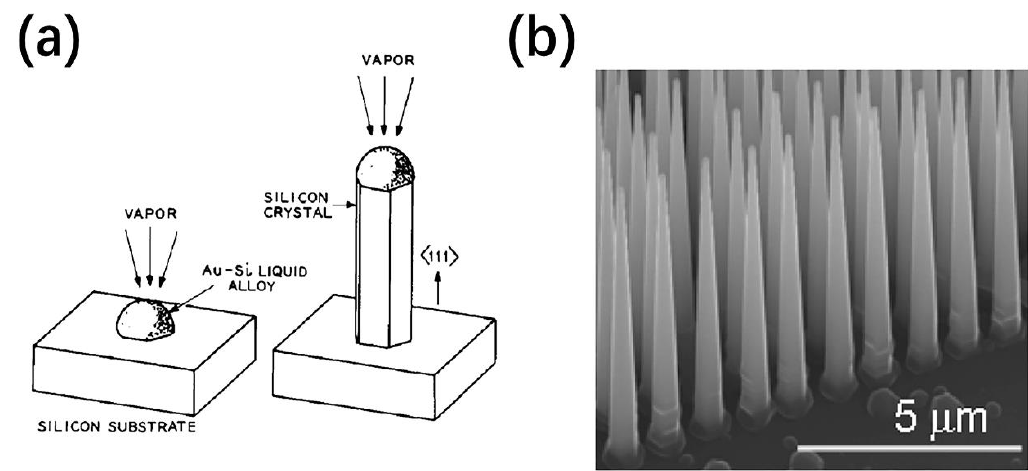
Figure 1. ( a ) Schematic illustration of the vapor-liquid-solid (VLS) growth method. Silicon crystal grows with liquid alloy at the tip [15]; ( b ) scanning electron microscope (SEM) image of SiNWs (nanowires) with significant tapering [25].